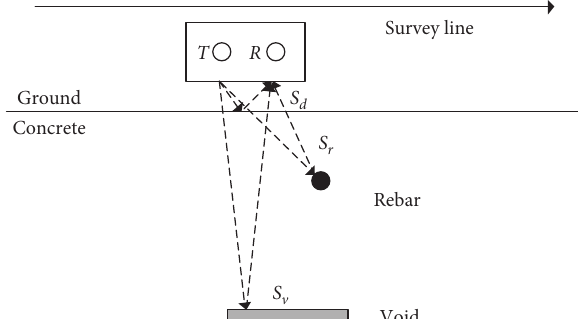
Figure 1: Multitarget echo submerged